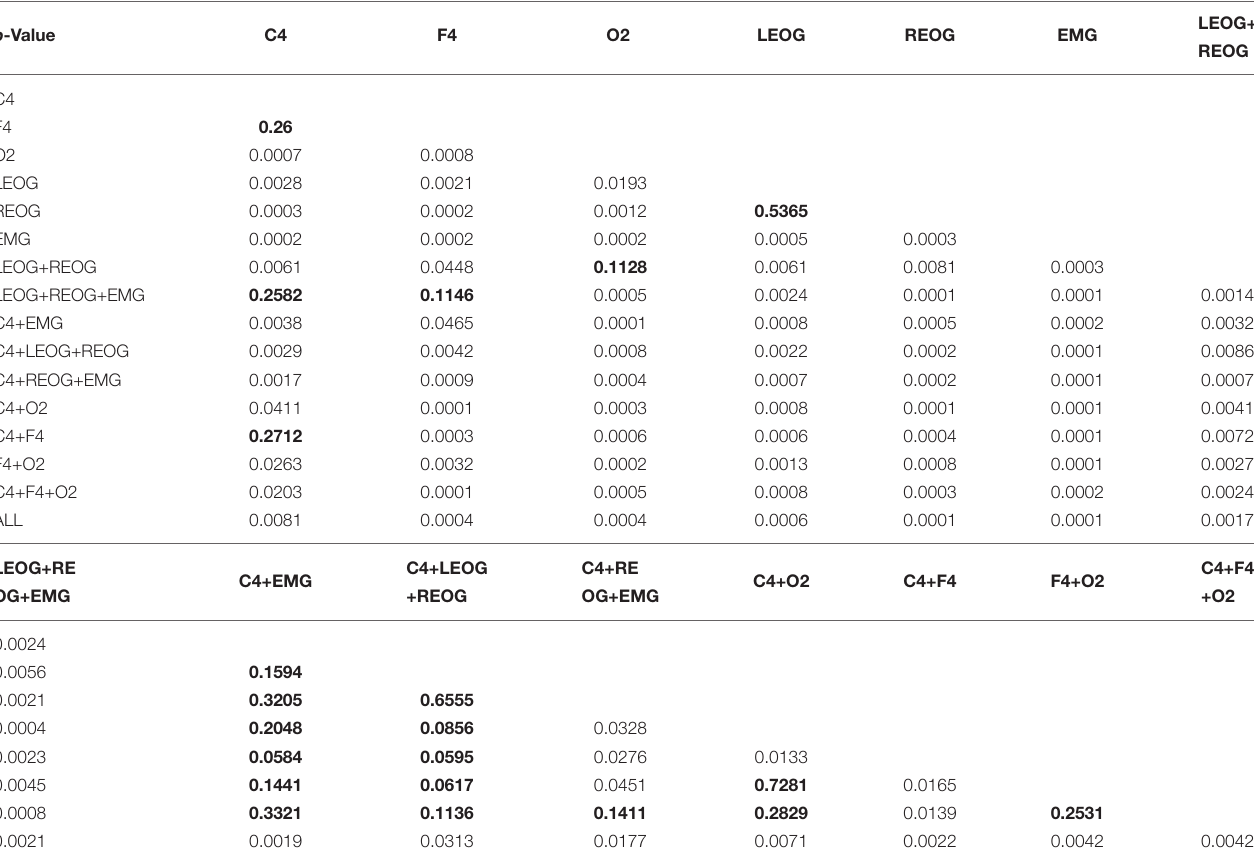
TABLE 7 | P -value of statistical test of different